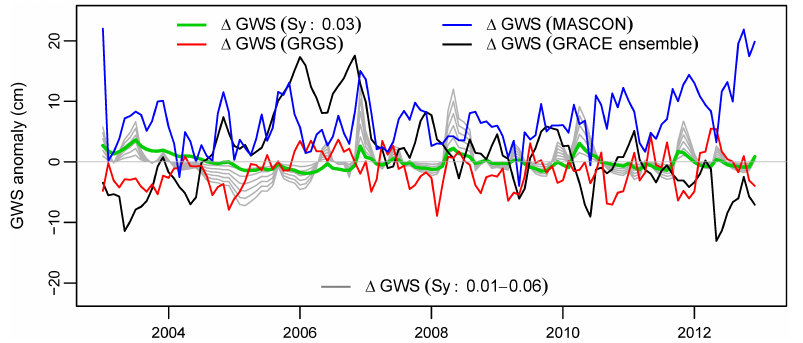
Figure 8. Estimates of in situ (cid:49) GWS and GRACE-derived (cid:49) GWS time-series records (January 2003 to December 2012) in the LVB show substantial variations among themselves. An ensemble mean (cid:49) SMS (three GLDAS LSMs: CLM, NOAH, and VIC) and an unscaled (cid:49) SWS are applied in the disaggregation of (cid:49) GWS using the GRCTellus GRACE (ensemble mean of CSR, GFZ, and JPL) and JPL-Mascons products.